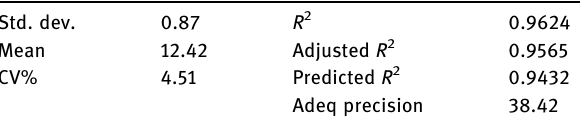
Table 14: Fit statistics for hardness Std. dev.